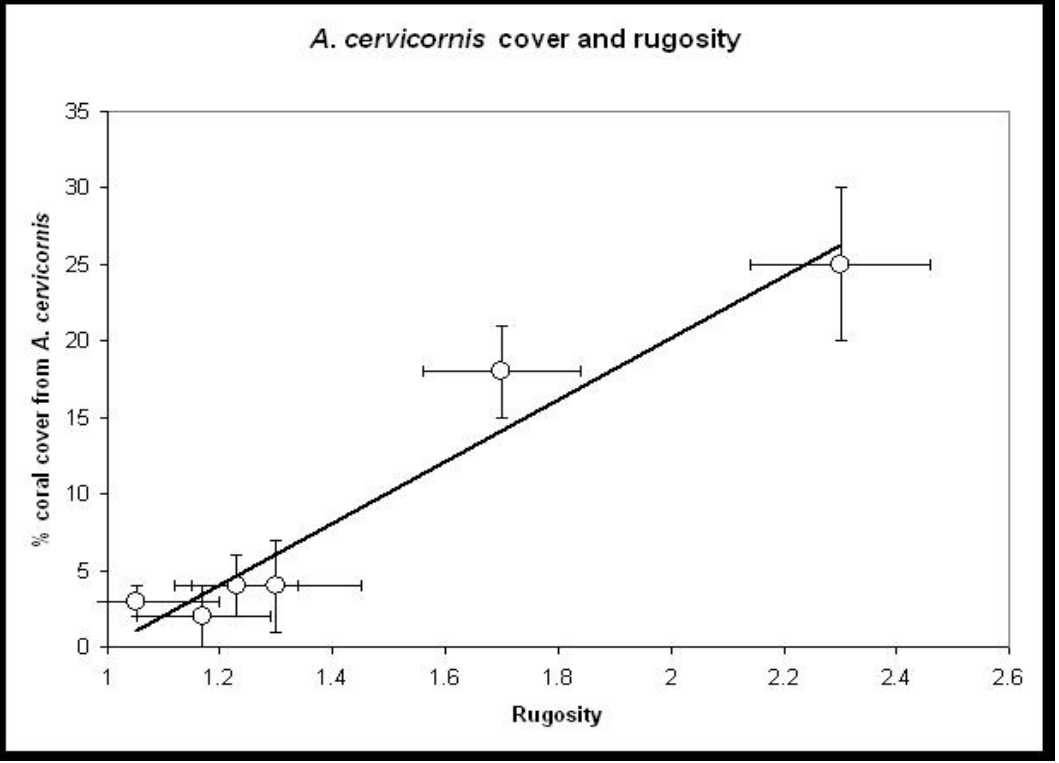
Figure 3. Percentage coral cover ± 1 standard error of A. cervicornis colonies against rugosity values ± 1 standard error, for Dairy Bull reef (2.3), M1 (1.17), New reef (1.7), Dancing Ladies (1.3), Rio Bueno (1.05) and Pear Tree Bottom (1.23). Mean rugosity values are in brackets. The line is a best-fit linear regression, with R 2 = 0.94. Adapted from